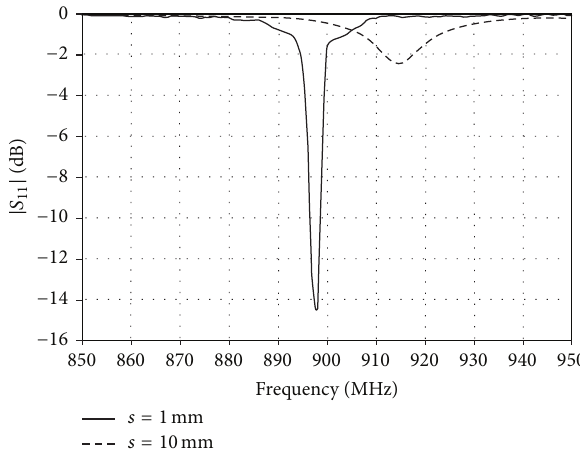
Figure 18: Simulated |𝑆 11 | characteristics for a large ground plane with 𝑔 = 40